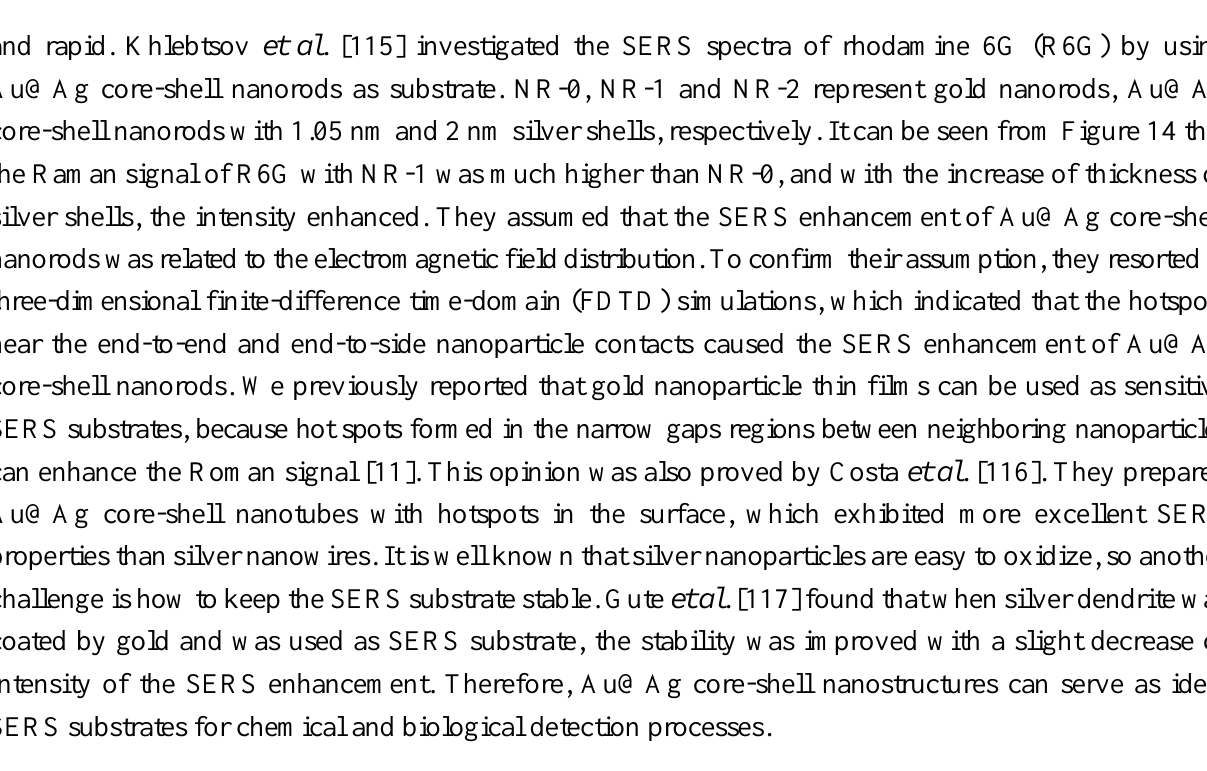
Figure 14. SERS spectra of R6G (1 μL, 80 μ M) deposited with NR-0 (1), NR-1 (2), and NR-3 (3) rods at a Au concentration of 14 g/L (reprinted with permission from [115]. Copyright (2013) American Chemical